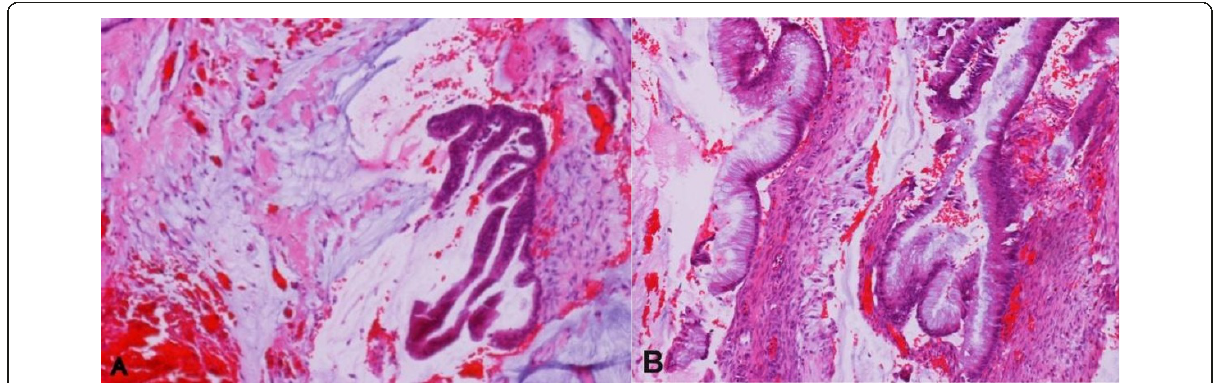
Figure 4 Extracellular mucin can originate from mucinous metaplasia, GBC or metastasis . A: Expansile pools of mucin with scattered glands, the mucinous epithelium exhibited cytologic atypia (H&E stain, X100), B: Neoplastic glands within the wall of gallbladder (H&E stain,